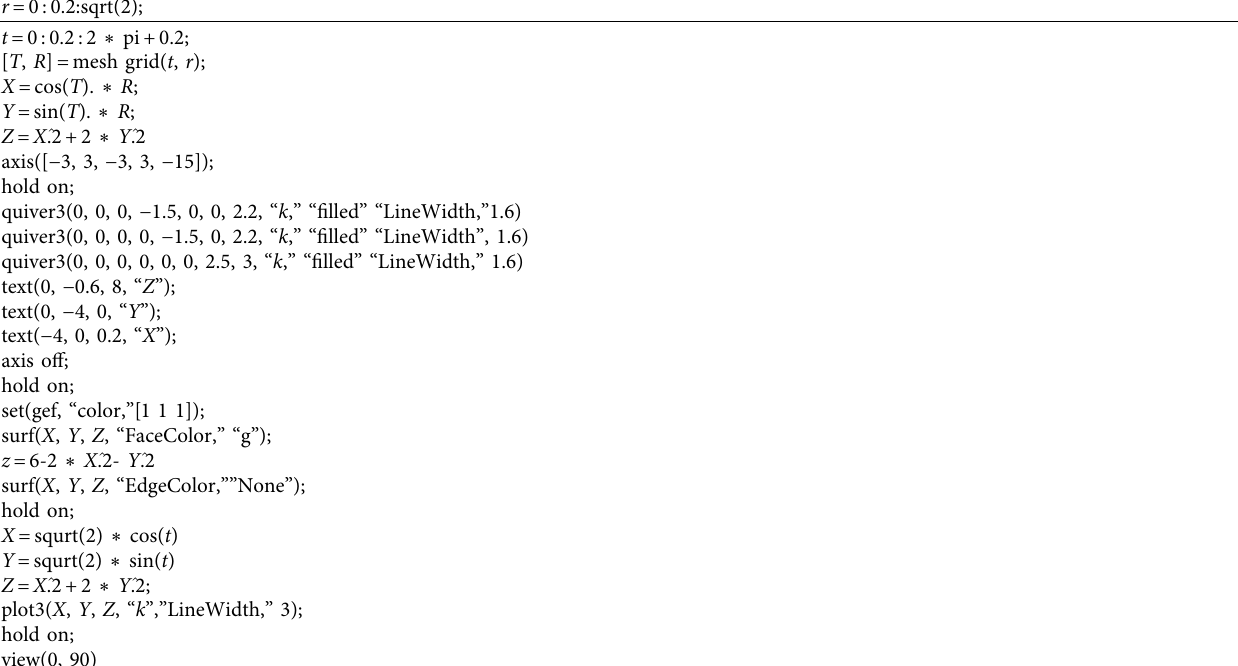
Table 3: Matlab program of geometry.